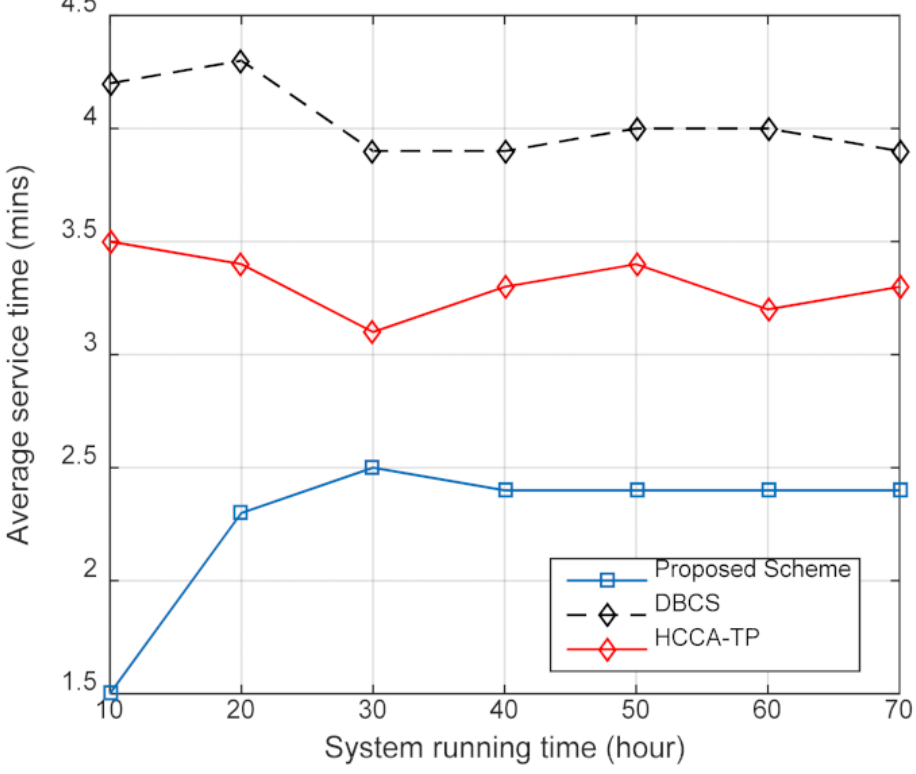
Figure 4. Comparing the average servicing times of the various schemes.